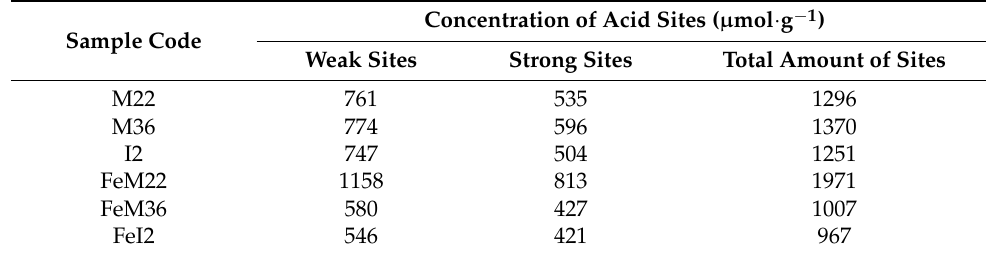
Figure 3. NH 3 -TPD profiles obtained for ( a ) pristine MWW zeolites; ( b ) iron-modified MWW zeolites. Table 3. Quantitative evaluation of acid centers of the pristine and Fe-modified MWW